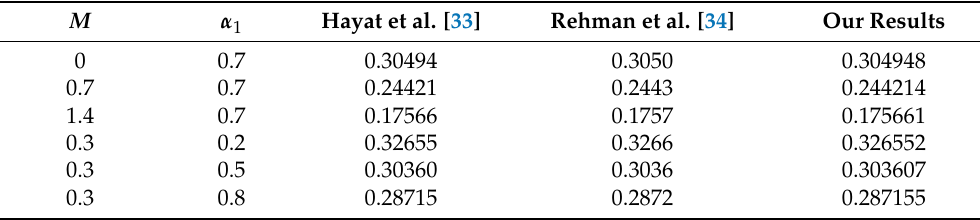
Table 1. The values of Re − 1/2 Nu for different values of M and α 1 when Rd = m = α 2 = α 3 = Ec = 0 in the absence of microorganisms. Hayat et al. [33] Rehman et al. [34] Our